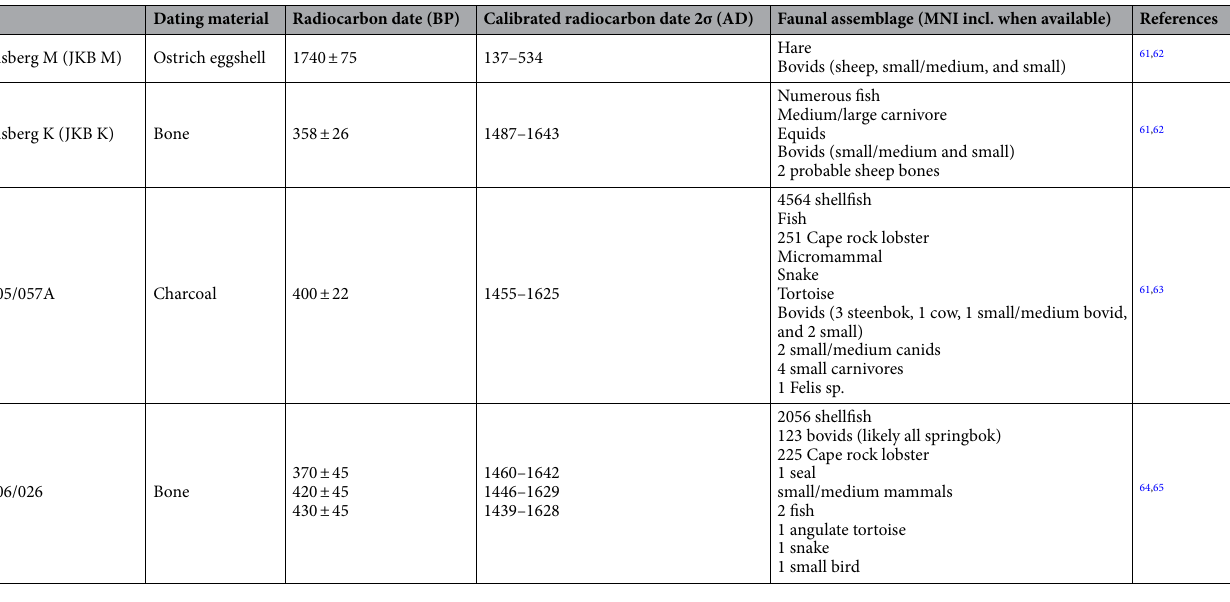
Table 1. Sites, radiocarbon dating material, radiocarbon dates (BP and cal AD), details of faunal assemblage, and